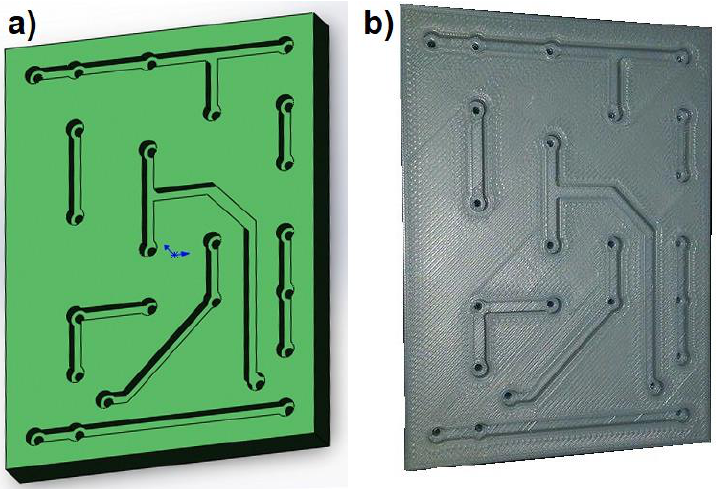
Figure 7. ( a ) Polymer substrate visualization. ( b ) Resulted 3D printed polymer substrate.